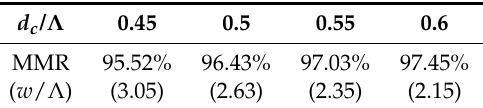
Table 1. MMR of Each Fundamental Mode with an Appropriate Gaussian Field Distribution ( w represents spot size for each Gaussian distribution).